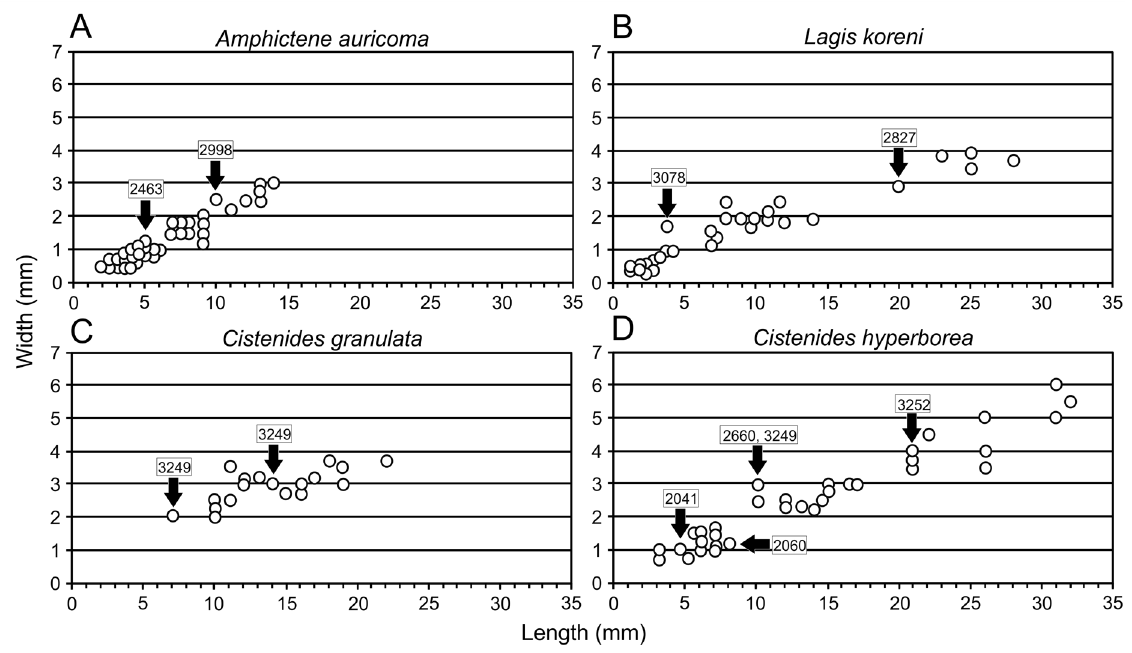
Fig. 3. Biometric features of the Pectinariidae specimens in BIOICE samples. A . Amphictene auricoma (O.F. Müller, 1776). B . Lagis koreni Malmgren, 1866. C . Cistenides granulata (Linnaeus, 1767). D . Cistenides hyperborea Malmgren, 1866. Specimens studied under SEM are indicated with black arrows and sample